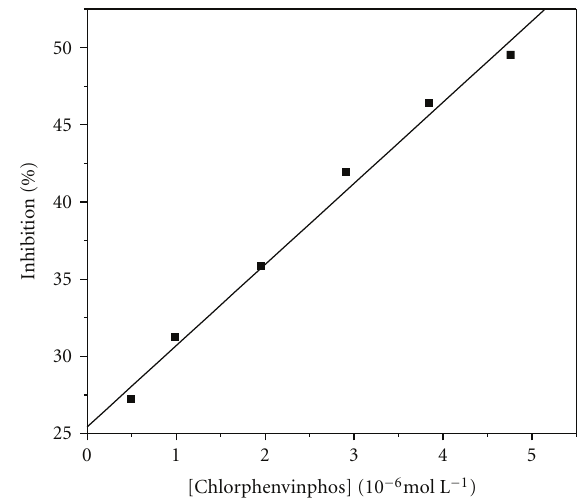
Figure 5: Analytical curve obtained with the CNTs-AChE biosensor for di ff erent concentrations of chlorphenvinphos in phosphate bu ff er pH 7.4 and 3 . 0 × 10 − 3 M AcSCh. Cell temperature is 30 ◦ C.